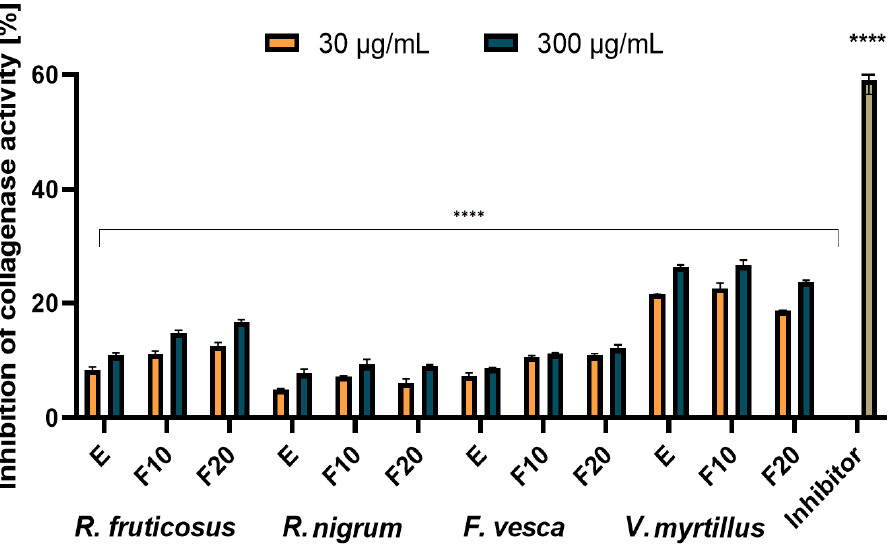
Figure 8. Collagenase inhibitory activity of R. fruticosus L., R. nigrum L., F. vesca L., V. myrtillus L. extract and kombucha ferments at concentrations of 30 and 300 µ g/mL. Data are the mean of three independent experiments, each consisting of two replicates per treatment group. **** p < 0.0001 versus the control.